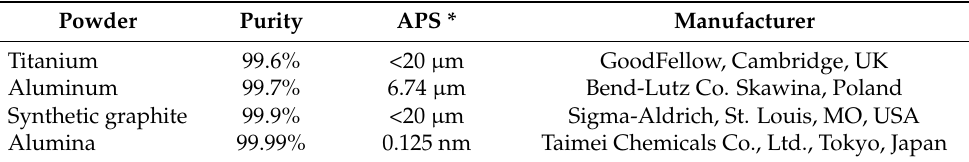
Table 1. The parameters of used powders. APS—average particle size. Powder Purity APS * Manufacturer Titanium 99.6% <20 µ m Aluminum 99.7% 6.74 µ m Synthetic graphite 99.9% <20 µ m 99.99% 0.125